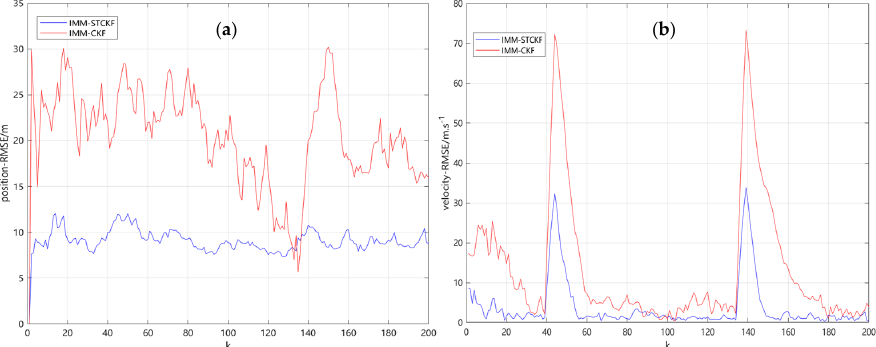
Figure 7. RMSE of position ( a ) and velocity ( b ). The red line is RMSE of IMM-CKF, the blue line is RMSE of IMM-STCKF.